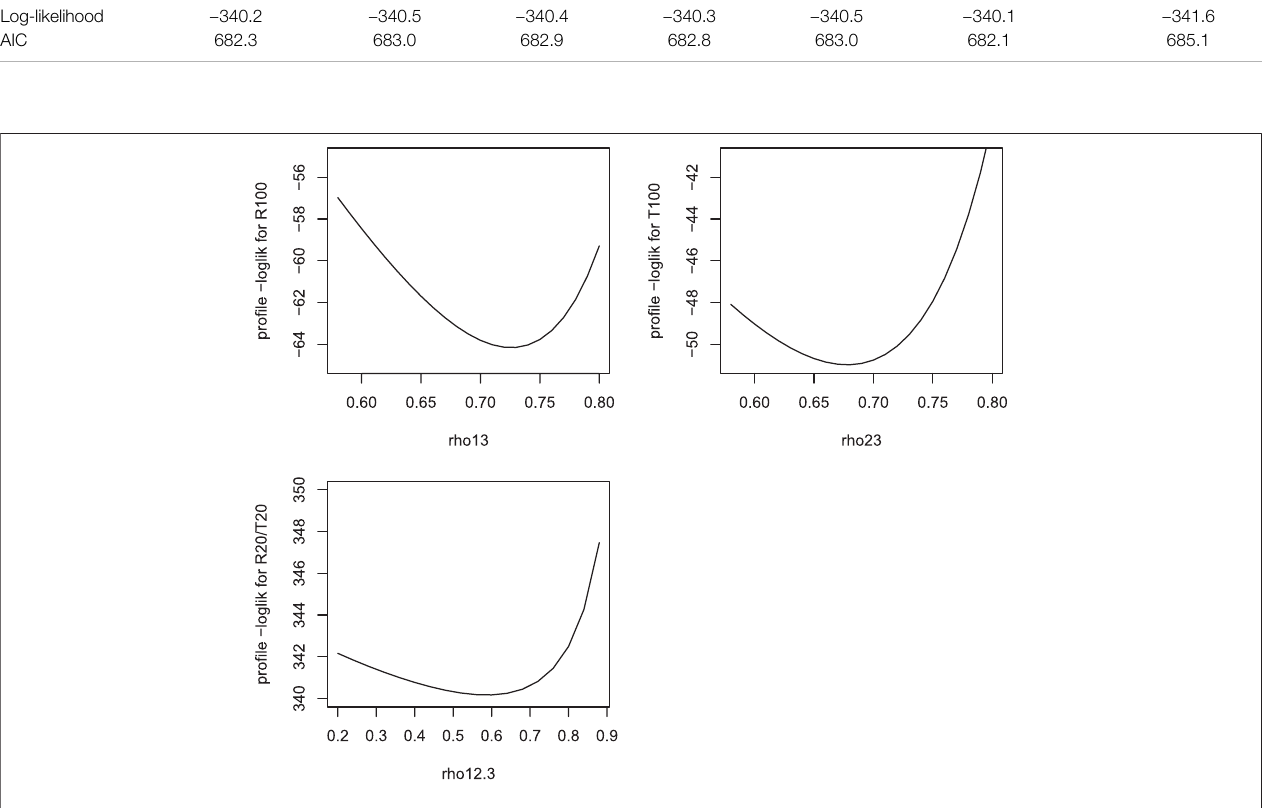
TABLE5| Modelcomparisonbasedonthesumof Eqs6 and 7 forgroupsR20/T20:thelog-likelihoodandAICvaluesbasedondifferentparametriccopulamodelsfor C 12;3 to represent the conditional dependence of ( MOR , UTS ) given MOE , with fi xed univariate models and fi xed bivariate Gaussian copulas C 13 for ( MOR , MOE ) and C 23 for ( UTS , MOE ). The notation t( ν ) indicates the bivariate t copula with degree of freedom parameter ν . Copula